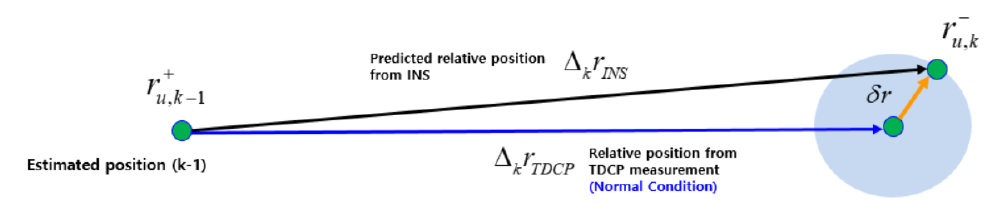
Figure 5. Relationship between INS and TDCP-based relative positions (normal condition).